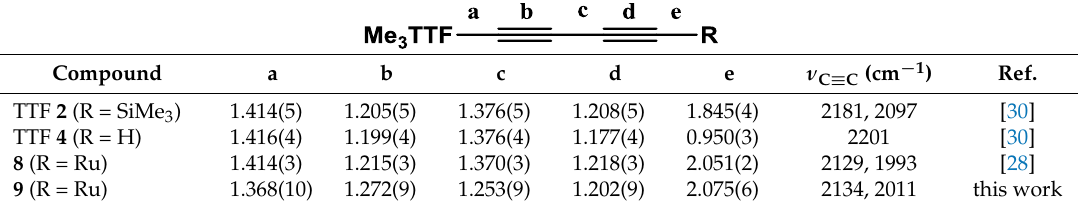
Table 2. Selected bond distances (Å ) in the mono and bis TTF Ru complexes together with TTFs 2 , 4 .